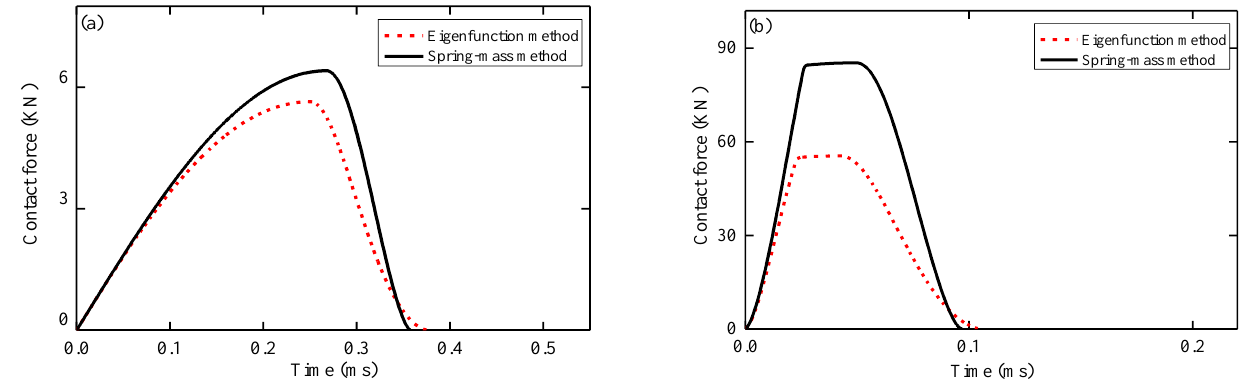
Table 5. Impulse ( P ), contact work ( W ), energy absorption of the beam ( Ua ) and kinetic energy loss of the sphere ( ΔE ) of eigenfunction method and spring-mass method for the first and 91st repeated impact.